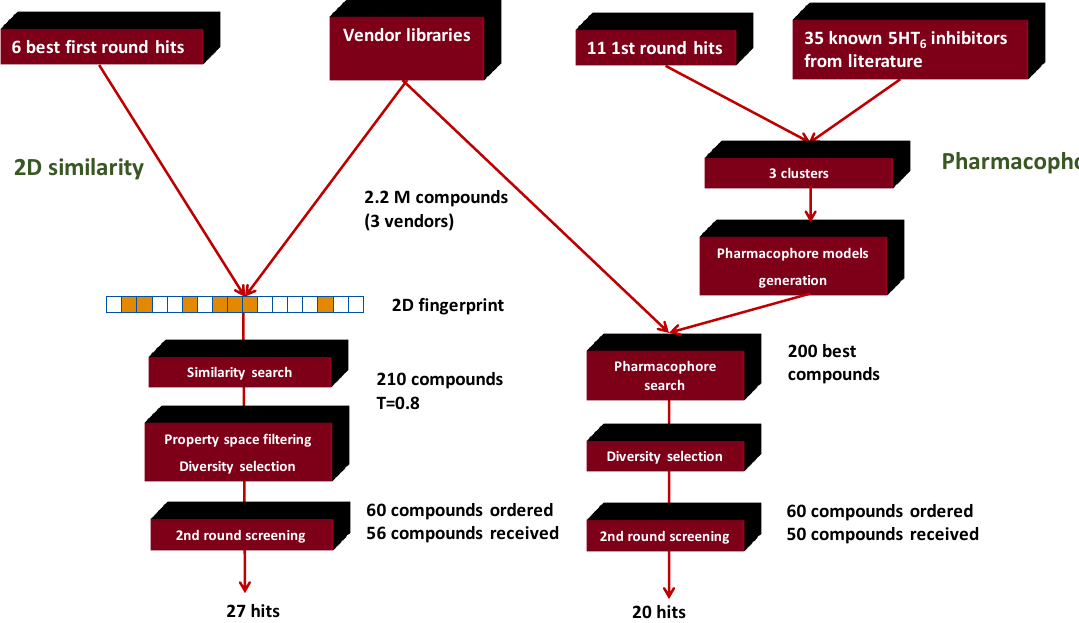
Figure 12. Parallel combined 2D similarity/pharmacophore matching workflow for 5 HT 6 antagonists. All three pharmacophore models were used to screen a combined vendor database which contained over 2.2 million vendor compounds. We checked manually the 50 top scoring molecules coming from each pharmacophore model searching (altogether 150) and we bought 70 of them from the three compound suppliers. Sixty of them were re- ceived and tested for 5-HT 6 receptor antagonism. In comparison, we also carried out a typical 2D similarity search using the six first round hits (IC 50 ≤ 1 μM) as seed compounds and the same 2.2 M vendor library was used as drug-like chemical space similarly to the pharmacophore-based in silico screening. As a cut-off value T = 0.8 was used, and 60 compounds were gained after property- and di- versity-based selection and ordered. Finally, 56 compounds were received. In our experience, pharmacophore search was found to be a particularly powerful tool for selecting compounds from large size compound libraries: 20 compounds of 50 were found active (>85% antagonist activity, hit rate = 40%). The average 2D similarity to the original first-round seed compounds was 0.586, which has already presumed novelty, and indeed, three novel chemotypes were found compared with the seeds. The average biological activity of the hits was IC 50 = 467 nM (most active hit—IC 50 = 15.3 nM). Pharma- cophore matching also lead to three novel chemotypes compared with the seed com- pounds used in the first round similarity search (Figure 13). Two novel heterocylic ring systems were particularly interesting and showed high antagonist activity. The closest analogue in the seed set is shown in Figure 13, which also revealed that T2D similarity values were less than 0.65; therefore, it could not be retrieved during the first round sim- ilarity search.